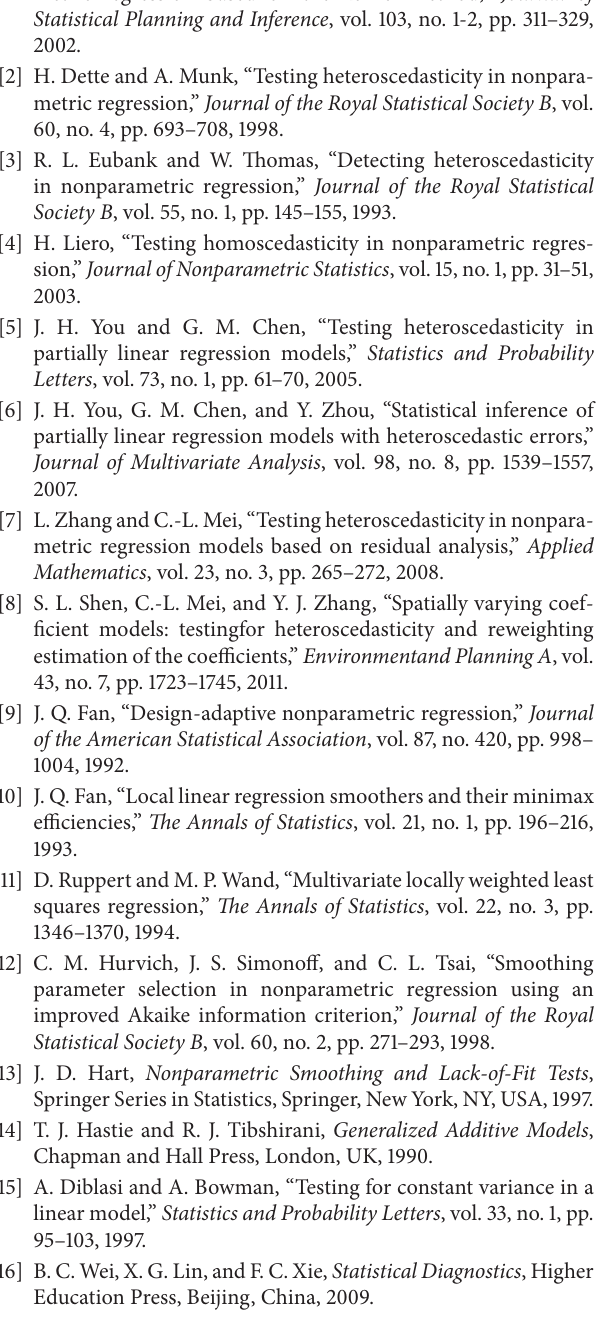
Figure 1: The original data of the response AT in model (18).